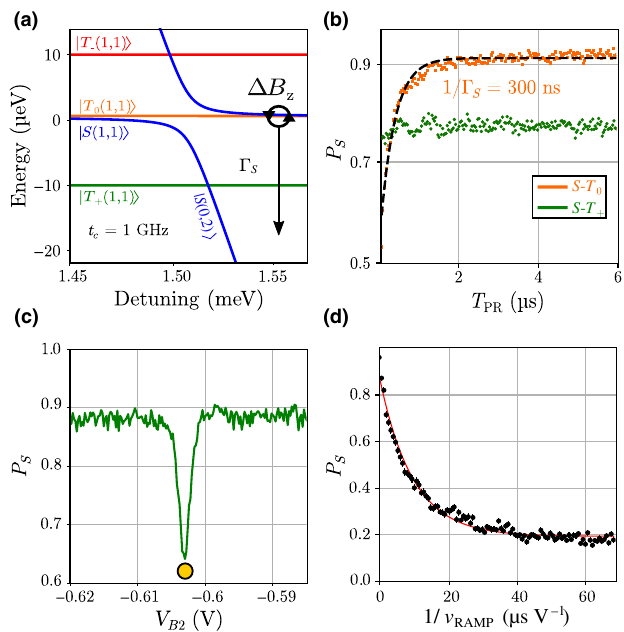
FIG. 2. Tools for the complete readout procedure: parity readout via T 0 relaxation hotspot, S - T + adiabatic transfor- mation. (a) Energy diagram of the different spin states of two electrons in a DQD as a function of (cid:2) . The fast relaxation channel of the T 0 is indicated via the black arrow. (b) Selective relaxation at the parity readout hotspot. The system is initialized in either a S - T 0 or S - T + mixed state and then pulsed during a variable time T HS at the parity-readout position. (c) Localization of the S - T + avoided crossing (indicated by the yellow circle) in the voltage- gate space. (d) Singlet return probability after a ramp through the S - T + avoided